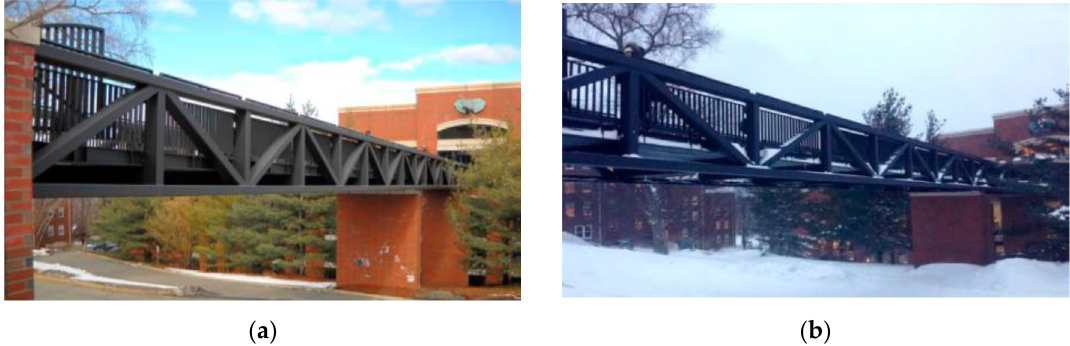
Figure 3. South-east view of Dowling Hall footbridge in ( a ) above-freezing, and ( b ) below-freezing conditions [54].